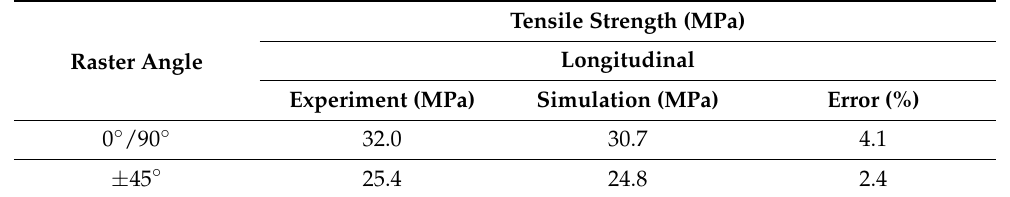
Figure 9. Layer thickness set (Method 1). Table 7. Modelling results for the raster angle set (Method 1).